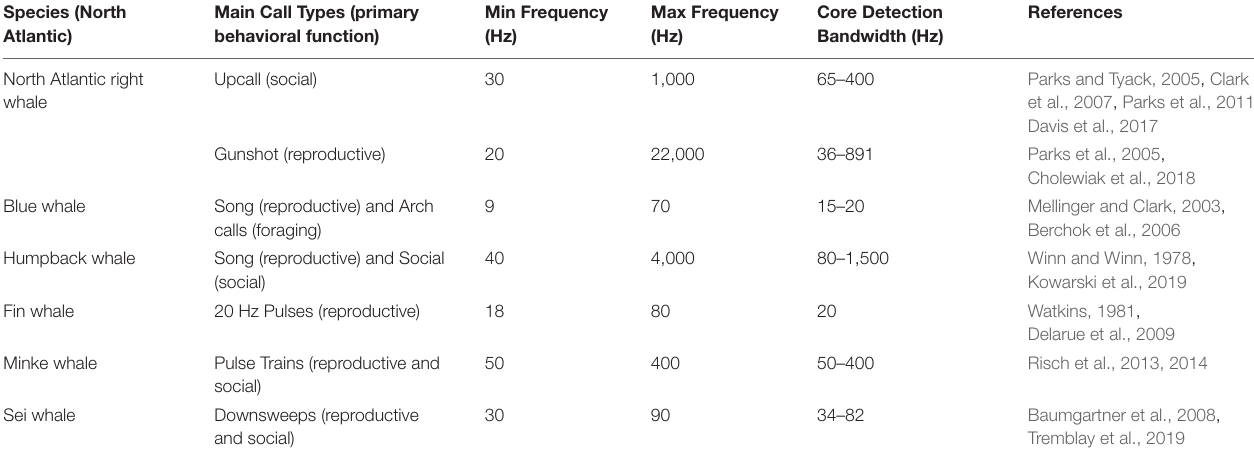
TABLE 1 | A list of the primary baleen whale species found along the Atlantic Outer Continental Shelf and their primary call type, call frequency range, and core detection bandwidth. Species (North